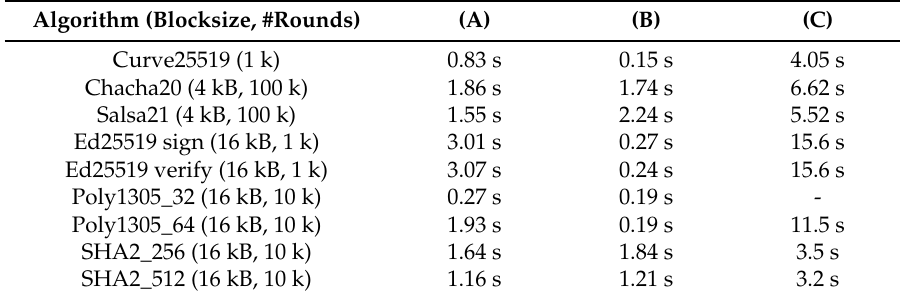
Table 4. Performance evaluation of HACL ∗ . (A) is HACL ∗ /C, (B) is libsodium, and (C) is WHACL ∗ . (1k : 1000, B : Byte) [17].